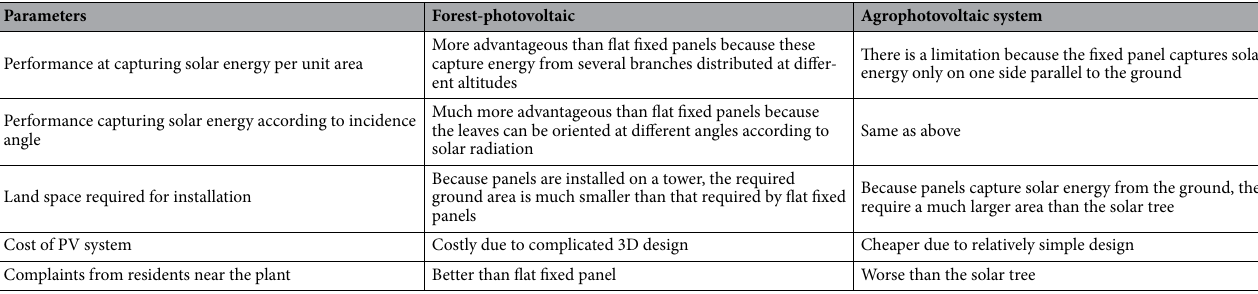
Table 6. Comparative evaluation of performance capturing solar energy between the forest-photovoltaic and agrophotovoltaic system.